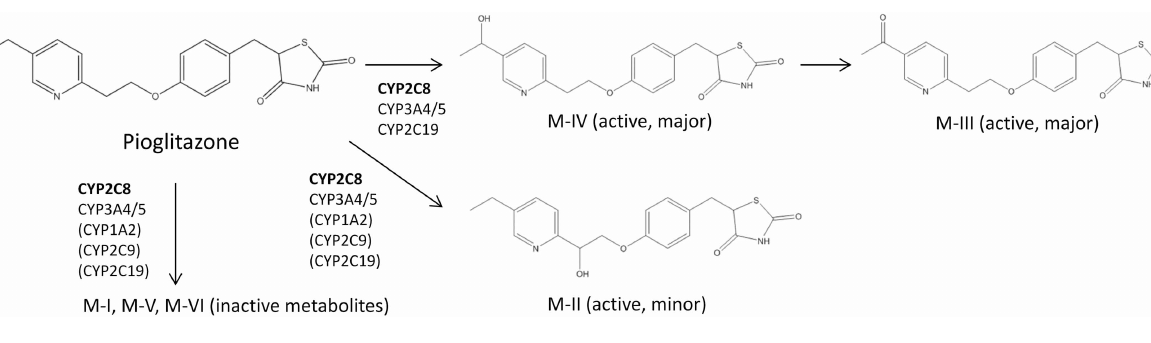
FIGURE 1 | Abbreviated Pioglitazone Metabolism Pathway. CYP2C8 is the major enzyme metabolizing pioglitazone and is shown in bold. Enzymes in the parenthesis are suggested to be involved in pioglitazone metabolism,